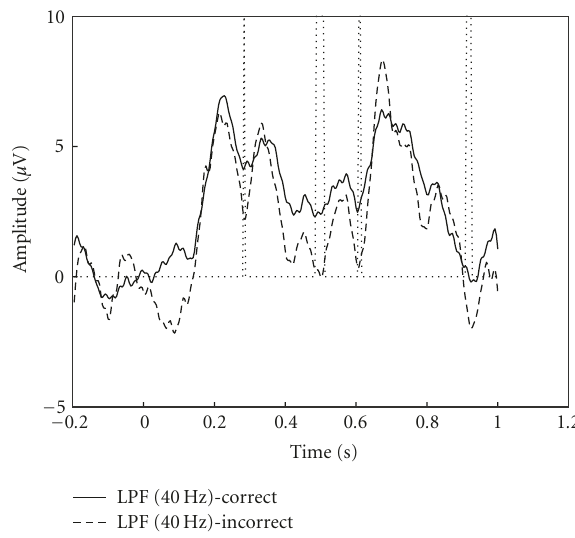
Figure 12: Comparison between averages of correct and incorrect EMD-denoised trials, from condition B. Dotted vertical line indicates time points at which di ff erence between two conditions was significant ( P < . 05).